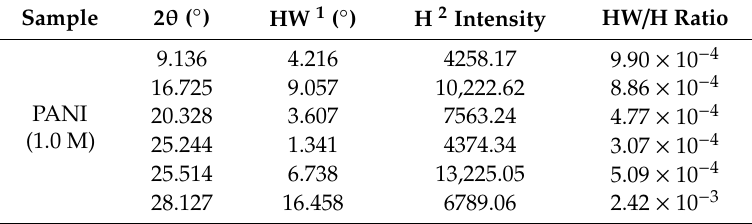
Table 2. XRD data analysis of PANI (1.0 M) and PANI (5.0